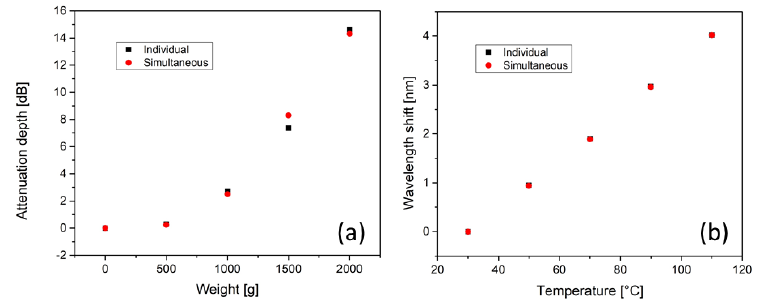
Figure 9. Individual and simultaneous measurement of ( a ) attenuation depth in the MI-LPFG and ( b ) wavelength shift in the CO 2 LPFG.